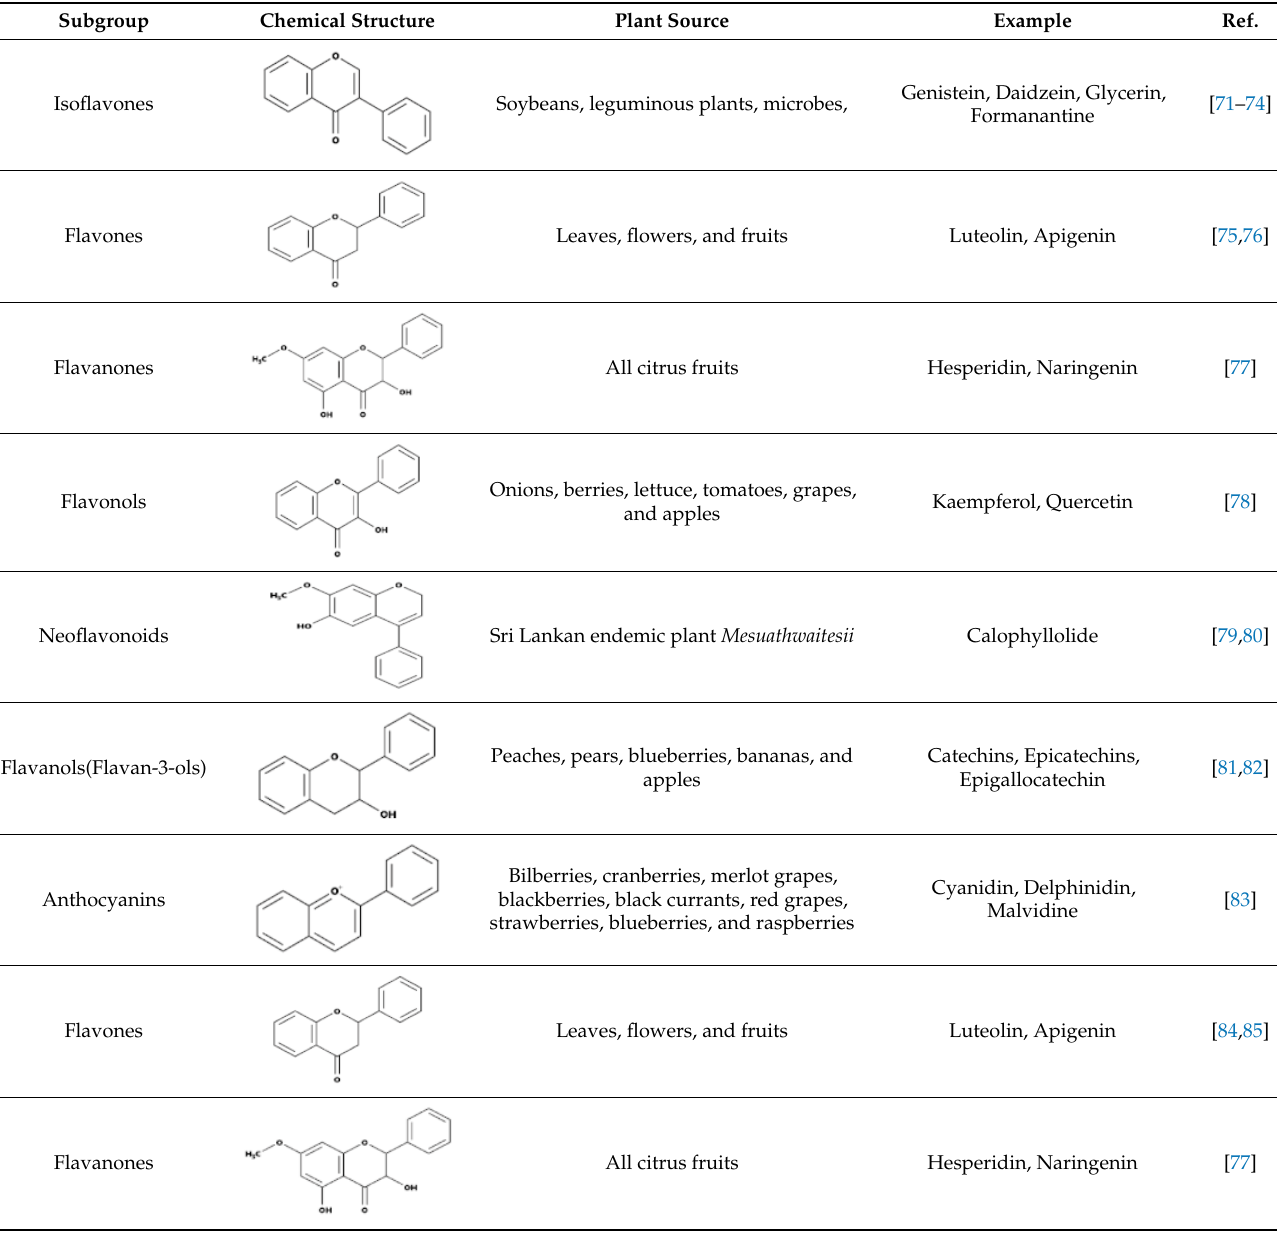
Table 1. A subgroup of flavonoids, their natural resources, and